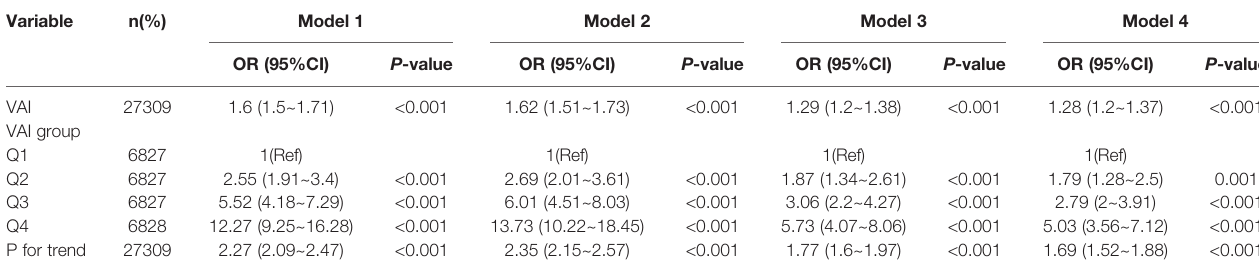
TABLE 3 | The association between VAI and IR in a multiple logistics regression model. Variable